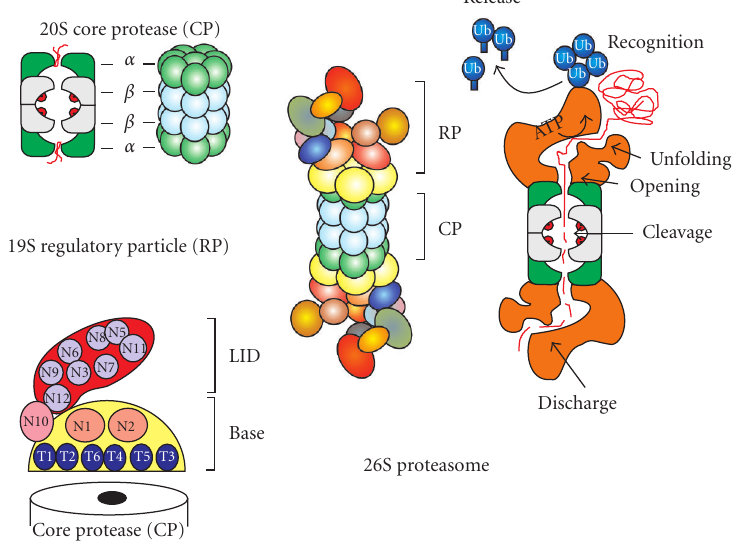
Figure 5: The structure of the 20S core and 19S regulatory particle. (http://plantsubq.genomics.purdue.edu/plantsubq/html/guide.html.)